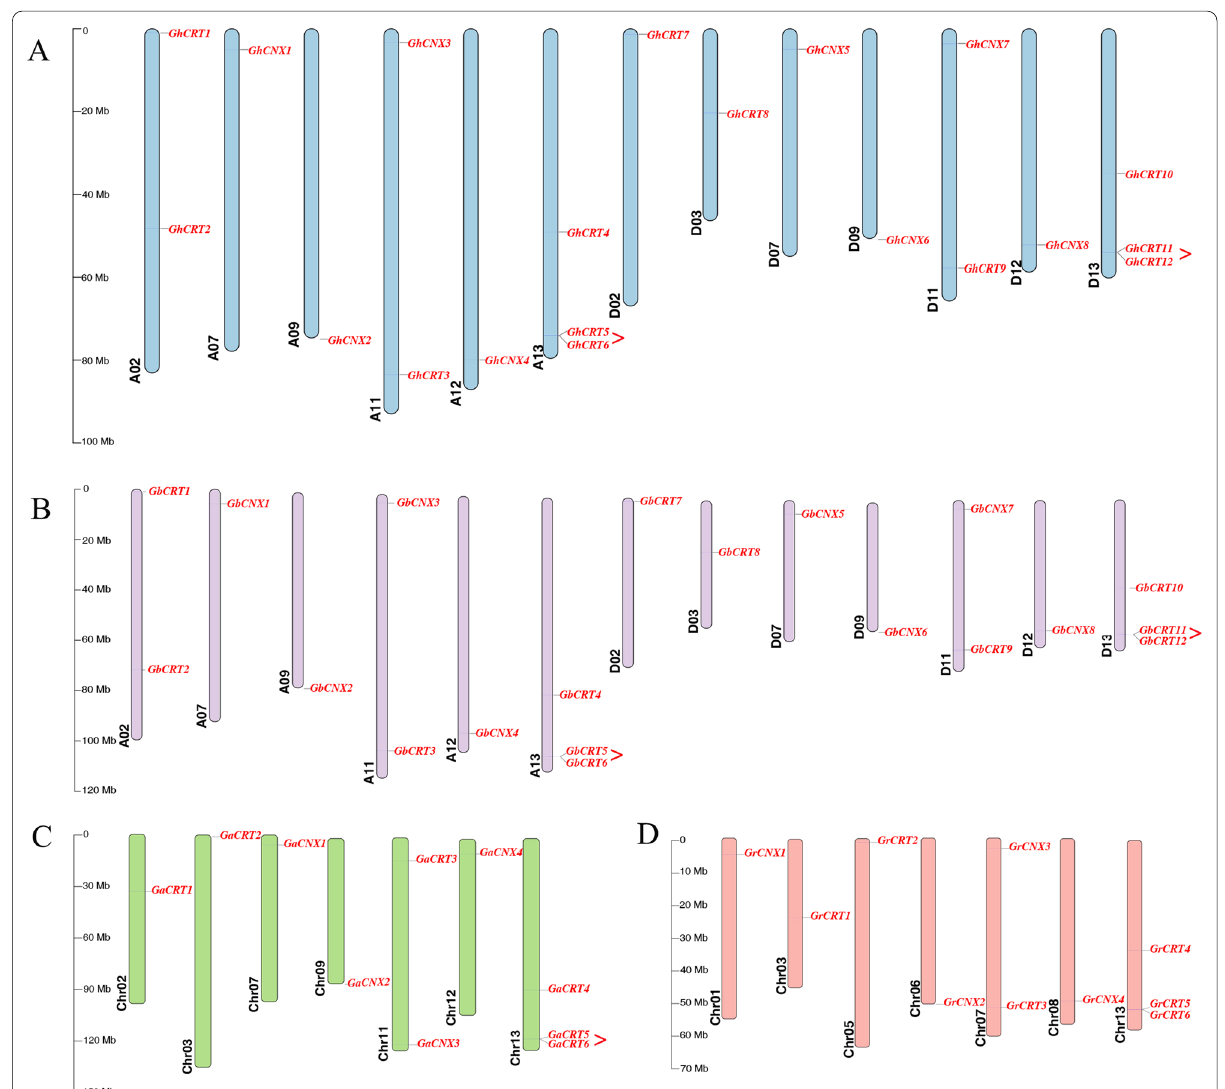
Fig. 2 Chromosome distribution of CNX family genes in four Gossypium species, G. hirsutum ( A ), G. barbadense ( B ), G. arboretum ( C ) and G. raimondii ( D